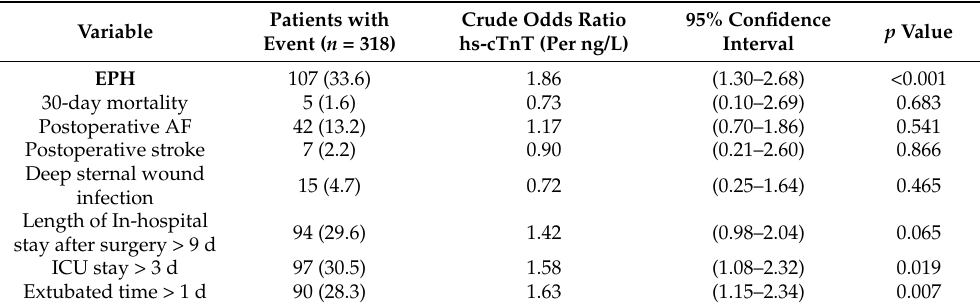
Table 4. Association of postoperative events with preoperative hs-cTnT levels (logged).